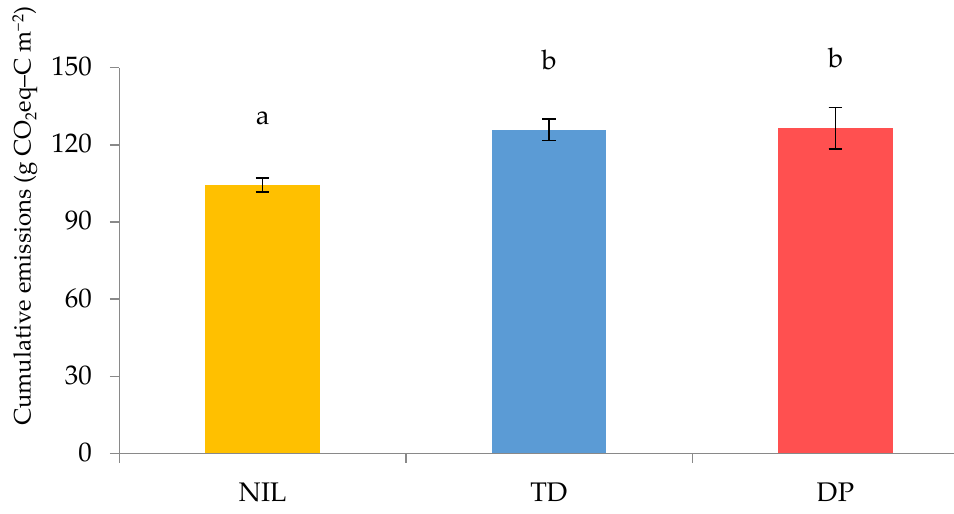
Figure 2. Cumulative greenhouse gas emissions expressed as the CO 2 –C equivalent (g CO 2eq –C m − 2 ) from non-treated soil (NIL) and soils fertilized with ammonium nitrate; top dressing (TD) and deep placement (DP). Di ff erent letters ( a , b ) indicate significant di ff erences ( p <